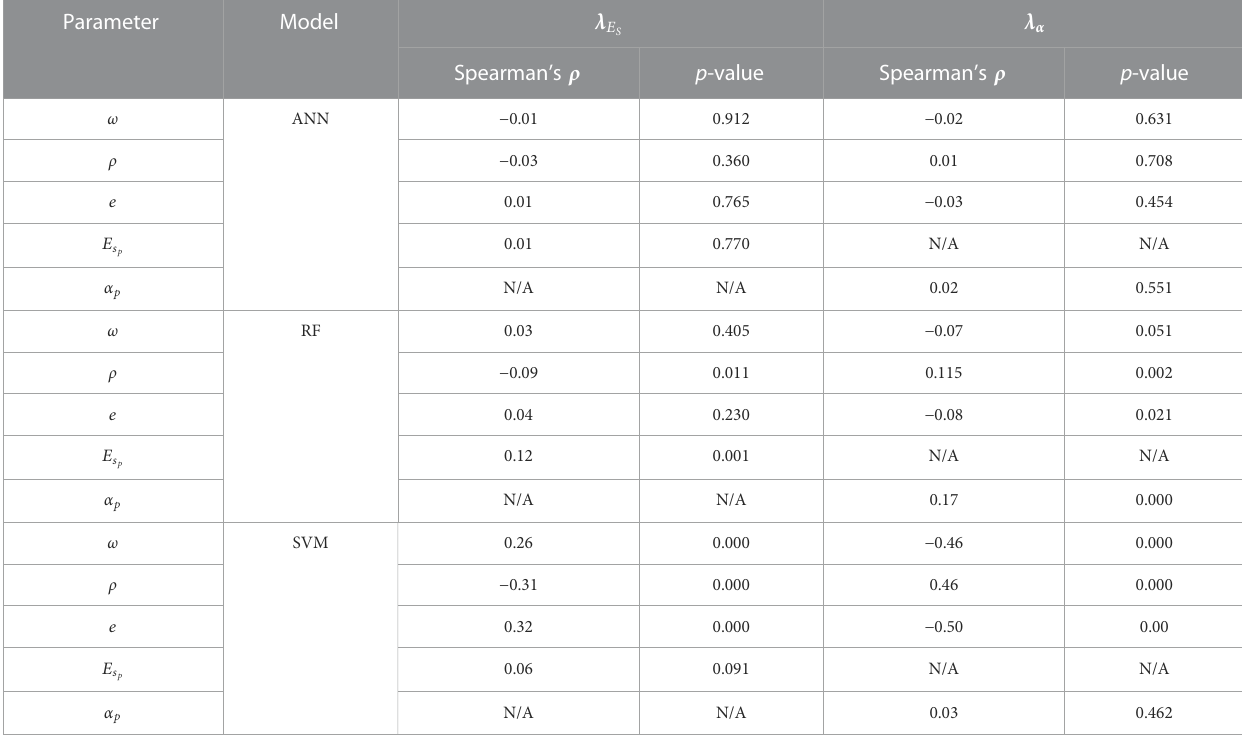
TABLE 3 Summary of results of Spearman ’ s rank correlation tests between biases and input parameters or predicted compressibility parameters.